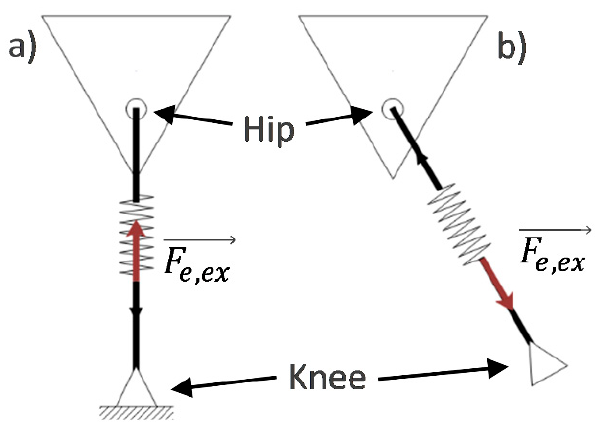
Figure 2. Rotation point of the exoskeleton superimposed with the rotation point of the hip joint: ( a ) stance phase; ( b ) swing Phase.